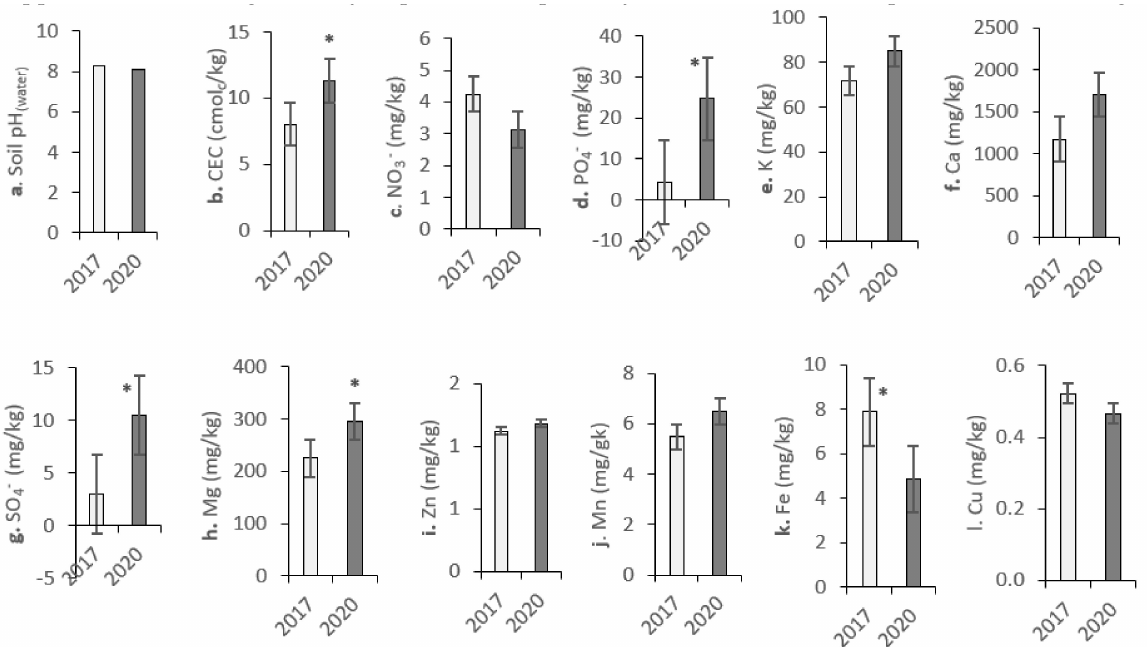
Figure 1. Soil chemical properties of organic transitioning fine sandy loam pastureland after three years of poultry. manure application under flood irrigation with no-till (* = significant in t -test at p =